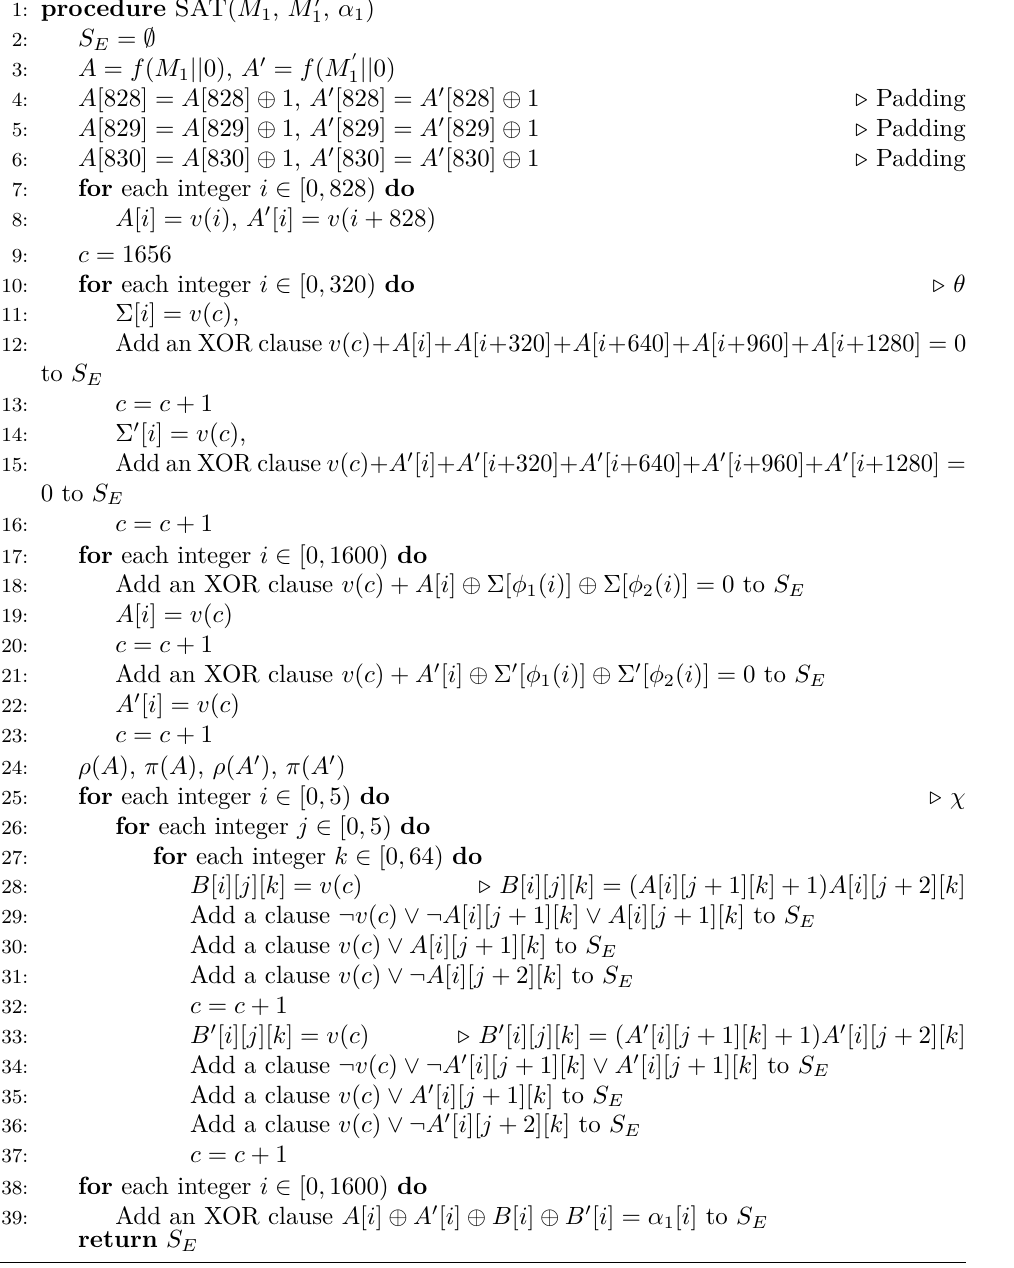
Algorithm 17 Converting a connectivity problem into a SAT